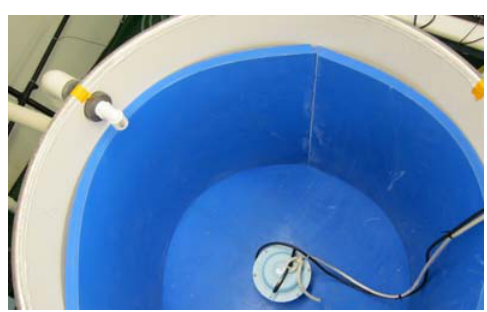
Figure 4. The noise exposure test